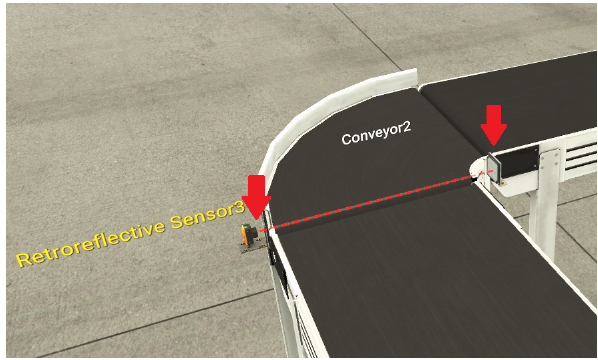
Figure 6. Retroreflective sensor and reflector.